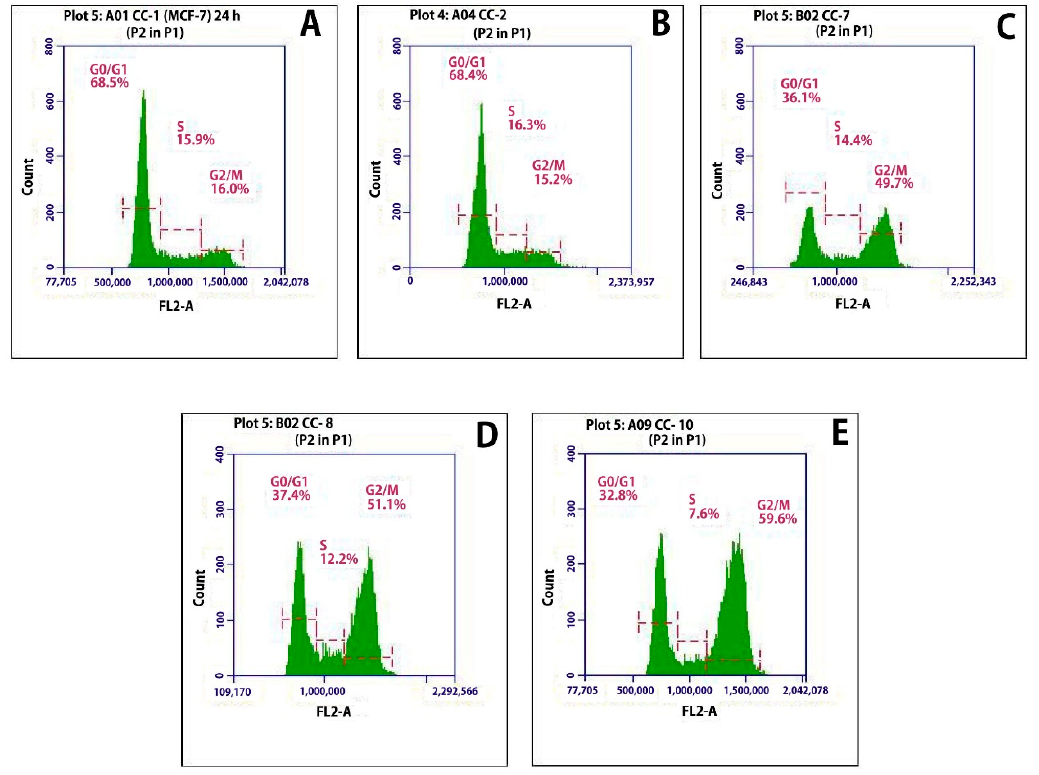
Figure 8. E ff ect on cell cycle of MCF-7 cells after 24 h of treatment. Control MCF-7 cells ( A Figure 8. Effect on cell cycle of MCF ‐ 7 cells after 24 h of treatment. Control MCF ‐ 7 cells ( A ), blank